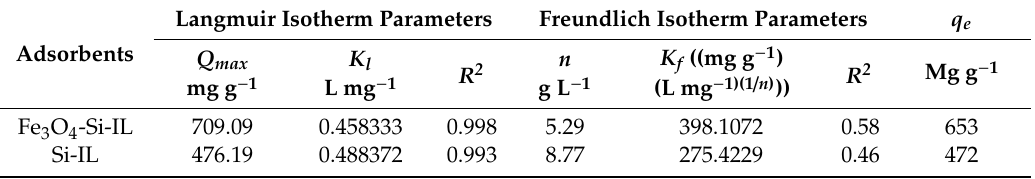
Table 1. Adsorption isotherm parameters of CR dye using Fe 3 O 4 -Si-IL and Si-IL composites at 298 K and optimum adsorption